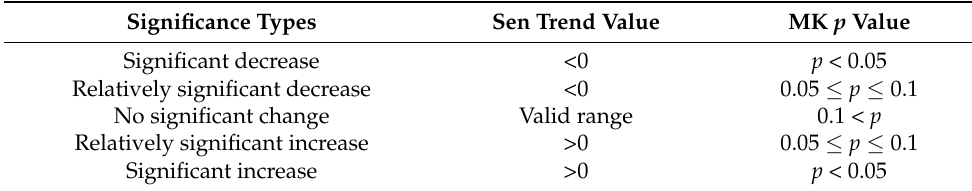
Table 3. Significance test of the trend of